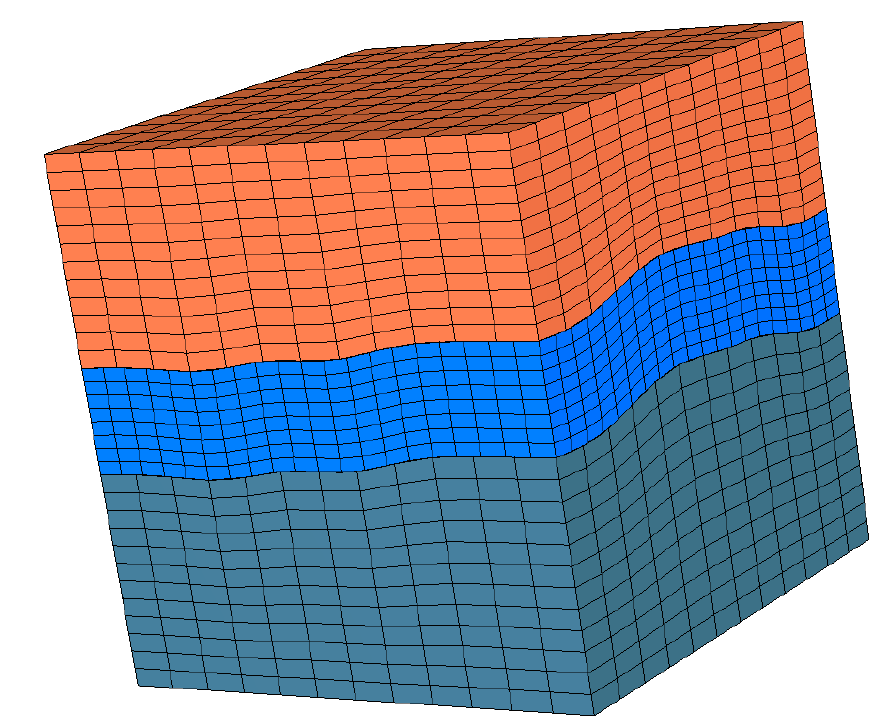
Figure 8. Subdomain meshes in Example 1 in Section 5.1.